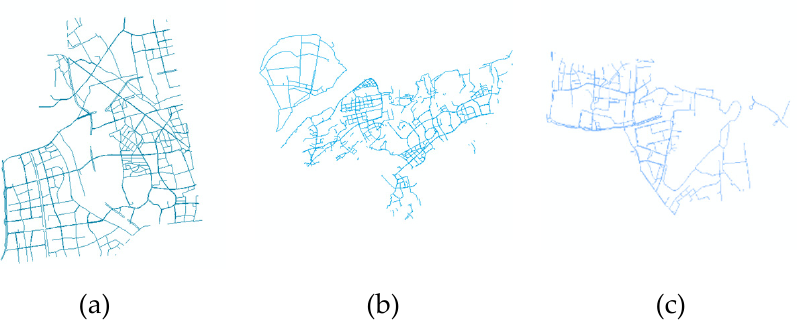
Figure 12 . Uniqueness verification data. (a) Gulou District; (b) Qinhuai District; and (c) Xuanwu District. Table 5. Units for magnetic